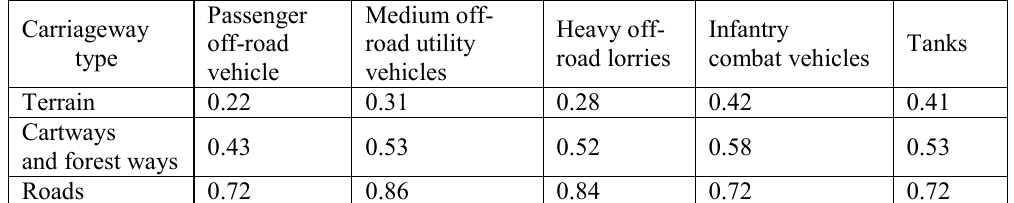
Table 1: The mean multiple coefficients of deceleration of military vehicle movements on free terrain and on communications